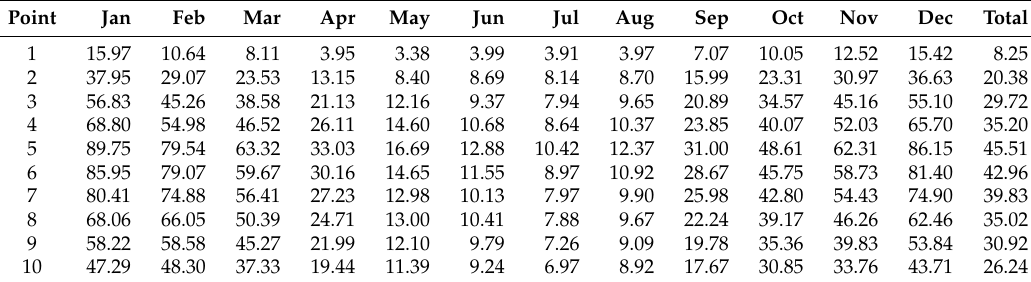
Table 1. Average monthly WEF (kW m − 1 ) for the 10 selected